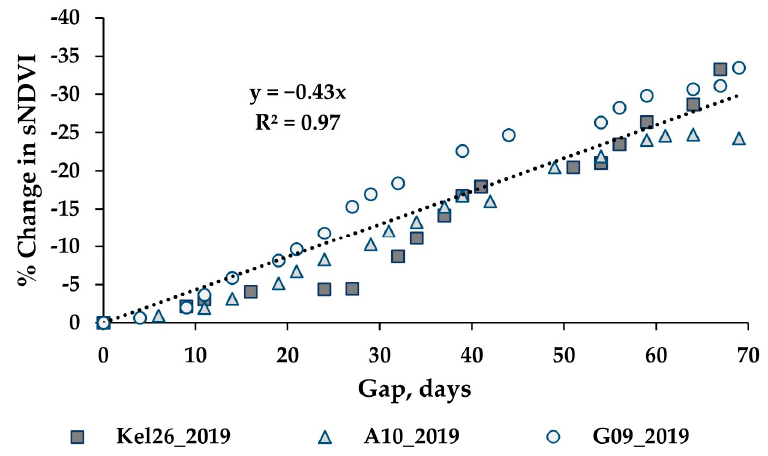
Figure 7. Evaluation of three wheat paddocks with near complete time series for the effect of the gap on the sNDVI. The increasing gap size is centred near mid-season. The percent change represents the relative change from a gap near zero and is based on the average time series of 100 pixels from each paddock. Each point represents the greatest percent change from DOY 200 to 365.